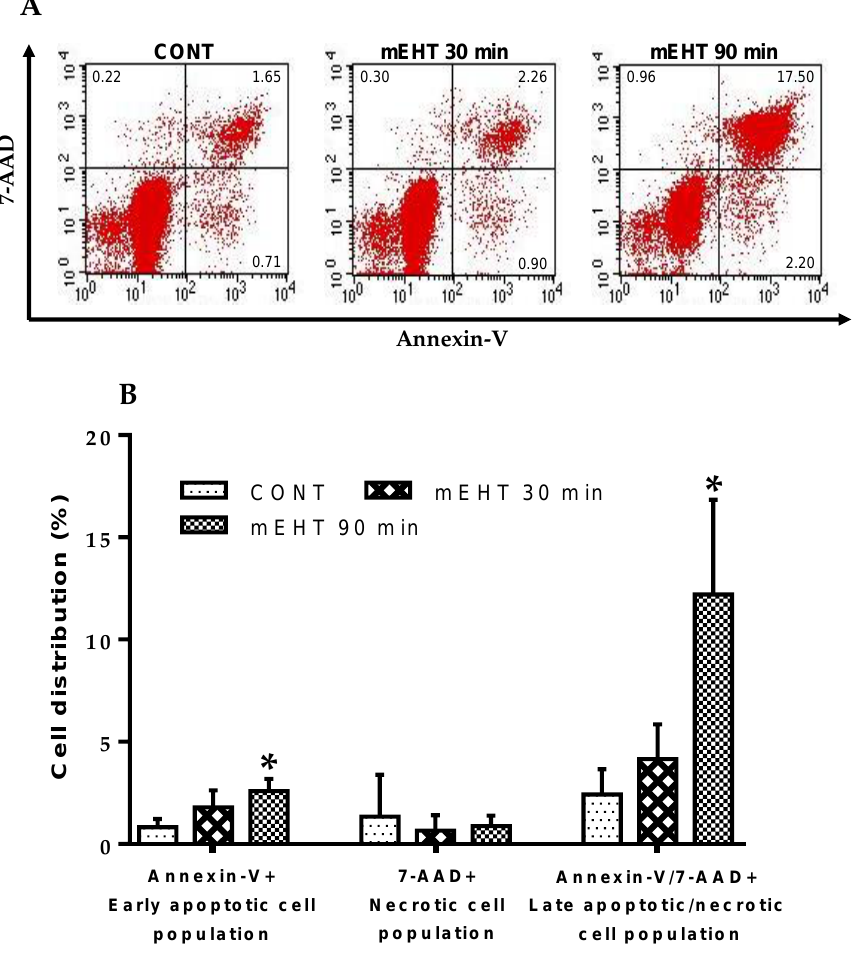
Figure 7. Dose-dependent induction of apoptosis and necrosis by mEHT in B16F10 melanoma cells. Tumor cells were mEHT-treated in vitro for the indicated duration of 30, 90 min. ( A ) Representative flow cytometry profiles for CONT and mEHT-treated B16F10 melanoma cells at 30 and 90 min treatment duration; ( B ) Dose effect of mEHT on cell death. Data represent average ± SEM of three independent experiments. CONT vs. mEHT (30, 90 min), unpaired t -test, * p < 0.05.